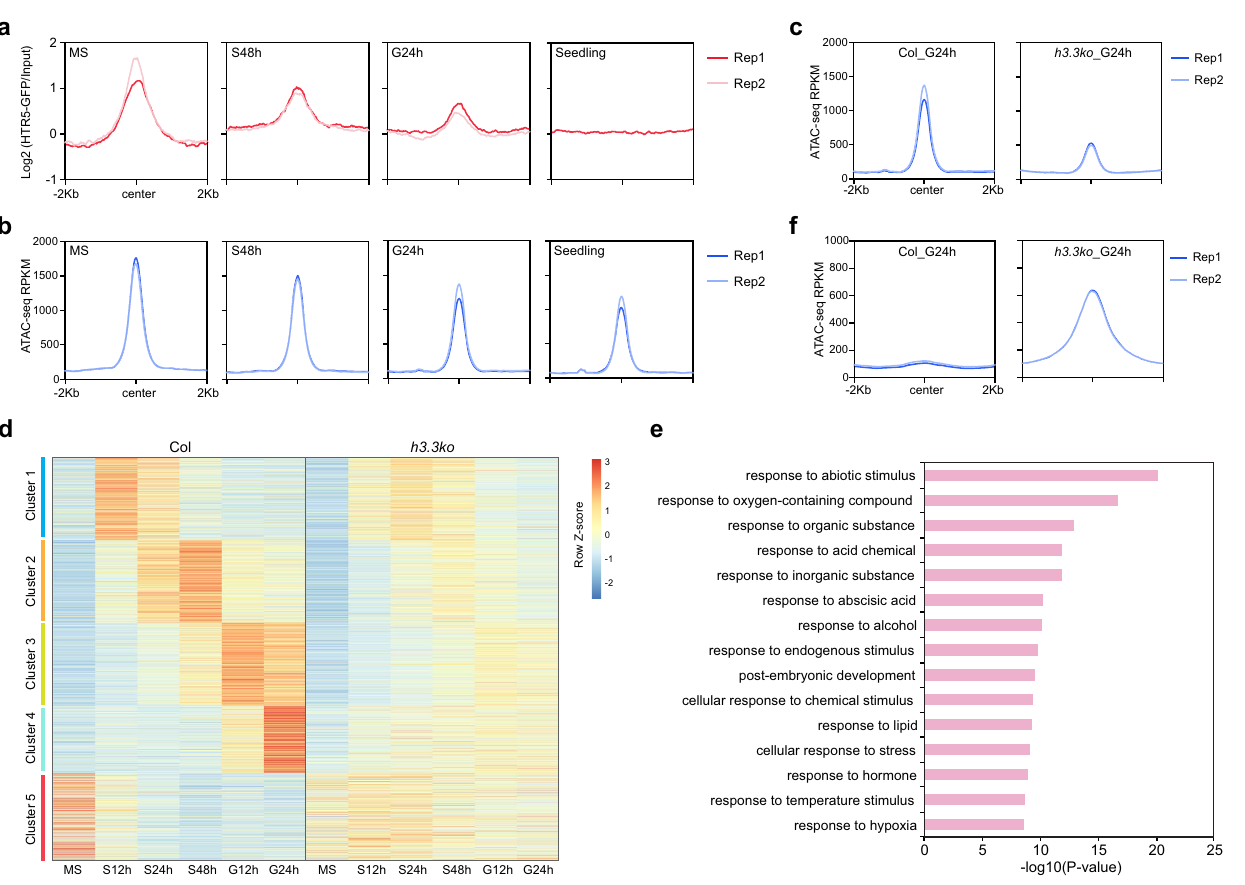
Fig. 6 | Loss of chromatin accessibility in h3.3ko is associated with gene mis- regulationduringgermination.a , b MetaplotofHTR5-GFPChIP-seq(a)andATAC- seq (b) signals in mature seeds, during imbibition and in the 10-day-old seedlings over accessibility decreased regions in mature h3.3ko seeds compared with Col. c . Metaplot of ATAC-seq signals in imbibed Col and h3.3ko seeds over accessibility signi fi cantly decreased regions in mature h3.3ko seeds compared with Col. d Heatmap showing expression pro fi les (z-normalized) of genes associated with